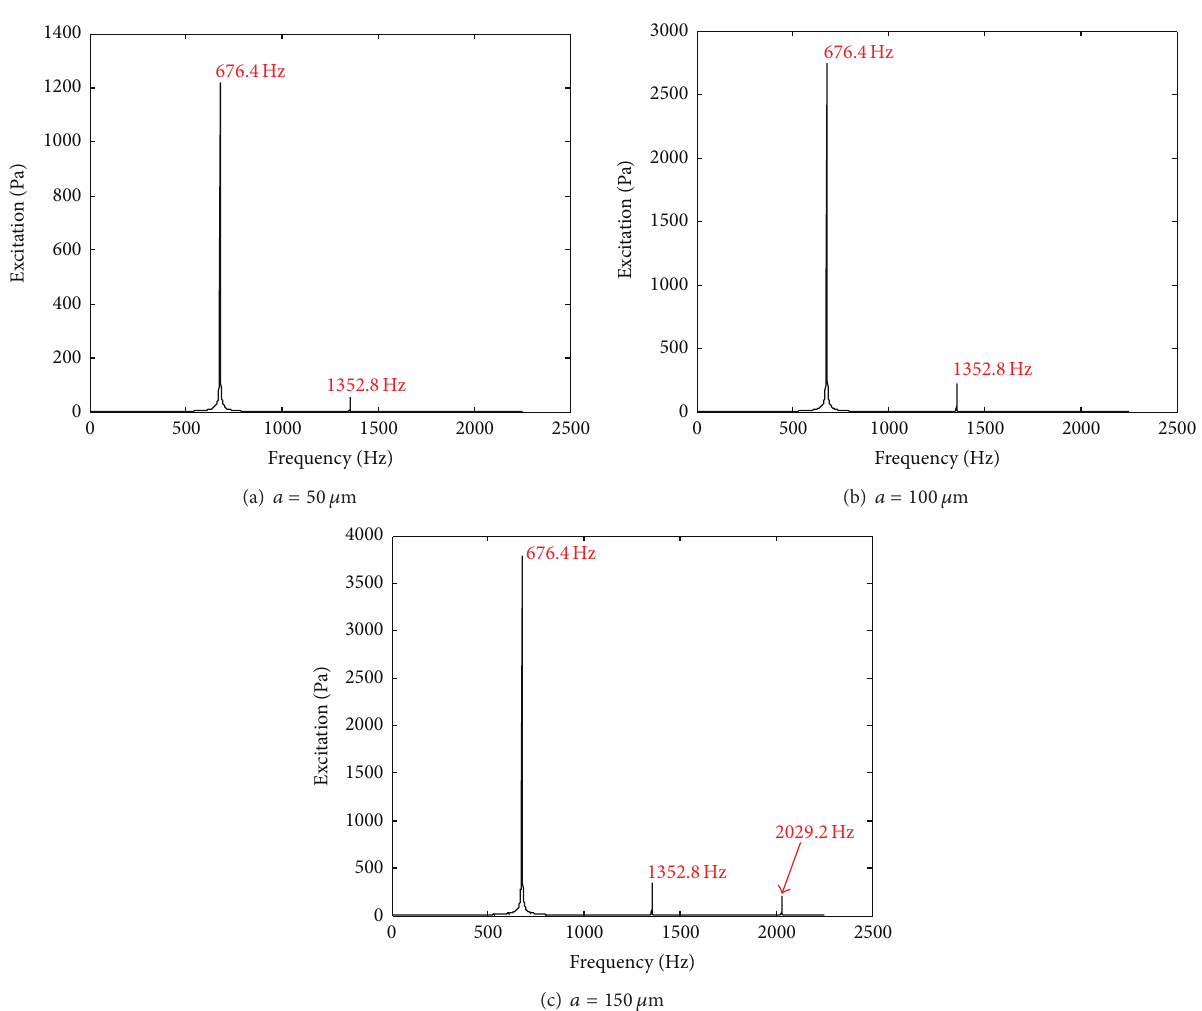
Figure 19: Calculation results of point D in different rotor whirling